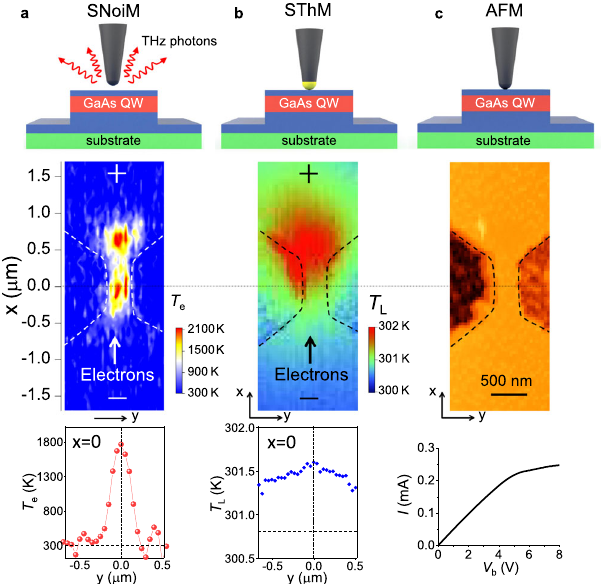
Fig. 1 Nanoscale thermal probing of heated electrons and heated lattice. a SNoiM. Top panel: A non-contact probe tip, 10 nm above the sample surface, scatters fl uctuating THz evanescent fi elds for detection. Middle panel: A 2D image of T e on a narrow conducting channel biased with V b = 8 V. Bottom panel: A 1D pro fi le of T e across the channel at x = 0. The signal averaging time is 300 ms/pixel for each pixel = 50 nm × 50 nm, where low- frequency fl uctuation in the signal roughly corresponds to Δ T e ~±100 K in the region outside mesa (without conduction electrons) and Δ T e / T e = ±7% in the region of mesa (with conduction electrons). b SThM. Top panel: A nanothermometer (shown with yellow dots) is in thermal contact with the sample surface to measure T L . Middle panel: A 2D image of T L taken on the same device as that for SNoiM with V b = 8 V. Bottom panel: A 1D pro fi le of x = 0. The dotted horizontal line shows the base T L across the channel at temperature ( T L = T base = 300.8 K). The signal averaging time is ~ 8 ms/ pixel for each pixel = 40 nm × 40 nm, where relative precision of measurements is roughly Δ T L ~±100 mK. c AFM. Top panel: AFM tip. Middle panel: A 2D topographic image of the device studied, with a 400 nm wide and 870 nm long constriction channel of a quasi 2D electron system in a GaAs/AlGaAs quantum well (see “ Methods ” ). Bottom panel: current – voltage